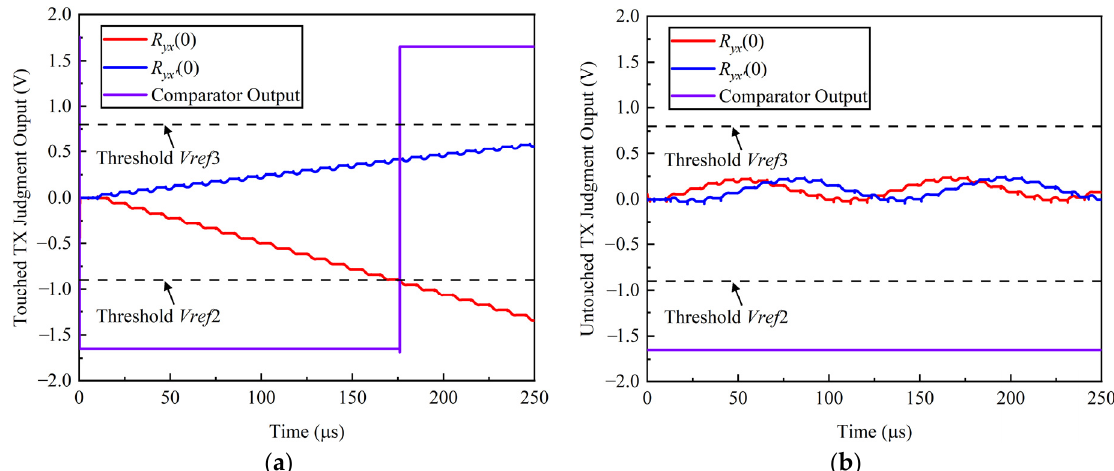
Figure 13. The time-domain waveform of the TX judgment module in the proposed cross-correlation AFE circuit. ( a ) Touched TX judgment output; ( b ) untouched TX judgment output.